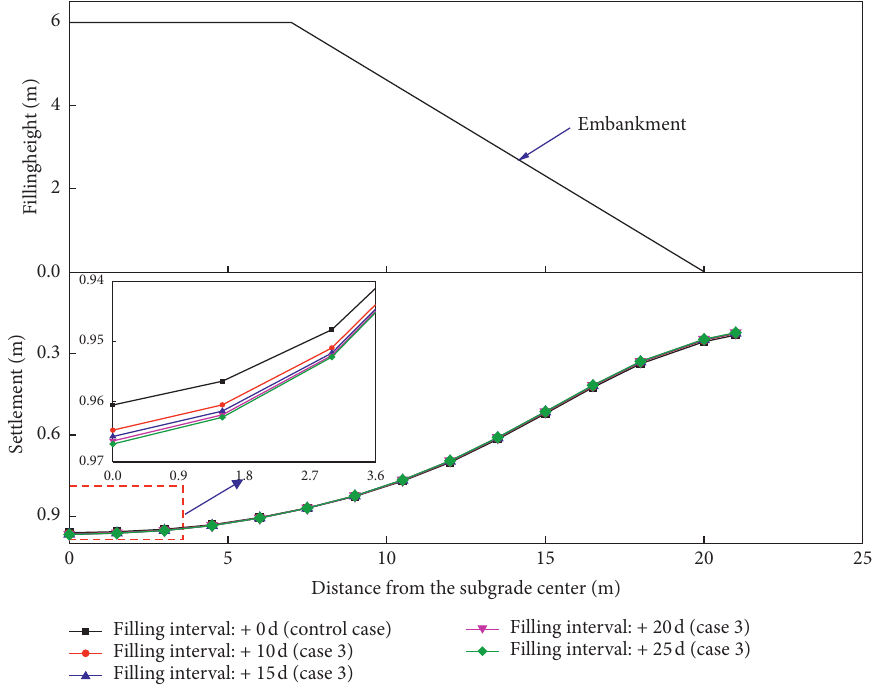
Figure 11: Influence of filling interval on the differential